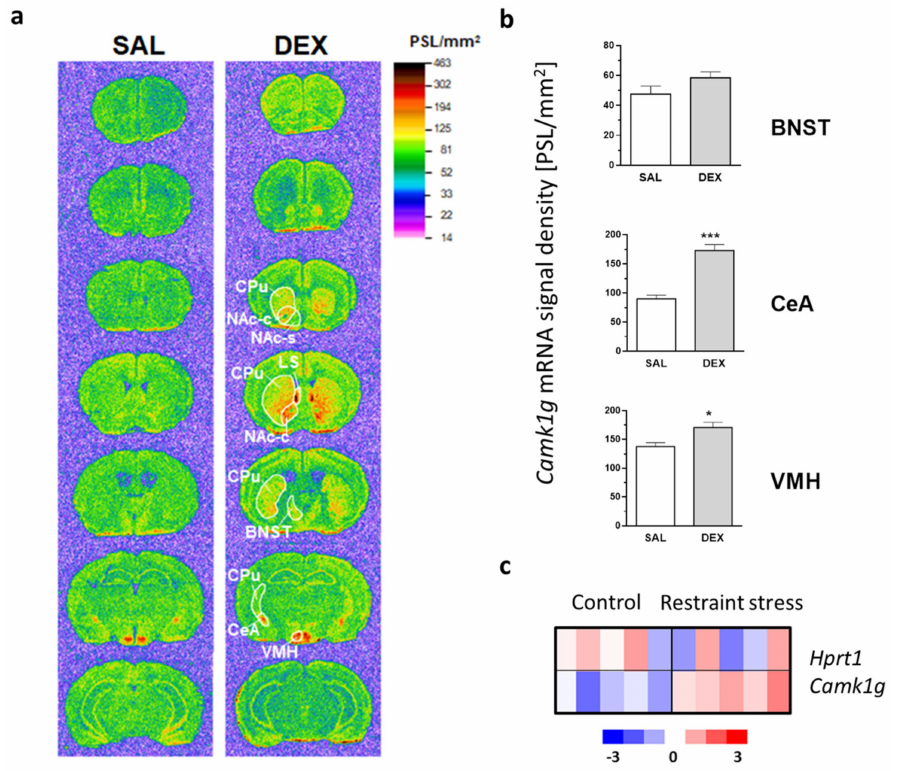
Figure 1. Camk1g distribution and regulation following dexamethasone (DEX) injection and restraint stress. ( a ) In situ hybridization autoradiograms depicting the brain distribution of Camk1g mRNA and its up-regulation by dexamethasone (DEX). The animals were sacrificed 4 h after the adminis- tration of DEX (16 mg/kg, i.p.) or saline (SAL). Optical densities of the autoradiograms, expressed in photostimulated luminescence units/mm 2 (PSL/mm 2 ), have been color-coded according to the scale in the upper right corner. The images are representative of 4 animals per group. ( b ) The plots show the results of a quantitative hybridization signal analysis in selected brain regions. The data, presented as mean ± SEM ( n = 4), were analyzed by the unpaired two-tailed t -tests. *— p < 0.05; ***— p < 0.001. ( c ) Changes in Camk1g mRNA abundance levels in the amygdala of 5 mice per group after restraint stress compared with a housekeeping gene (Hprt1). The heatmap shows a z-scored abundance of log2-transformed counts for each gene as measured with microarray profiling. T-test p -value: Camk1g = 0.002; Hprt1 = 0.46. Abbreviations: BNST—bed nucleus of stria